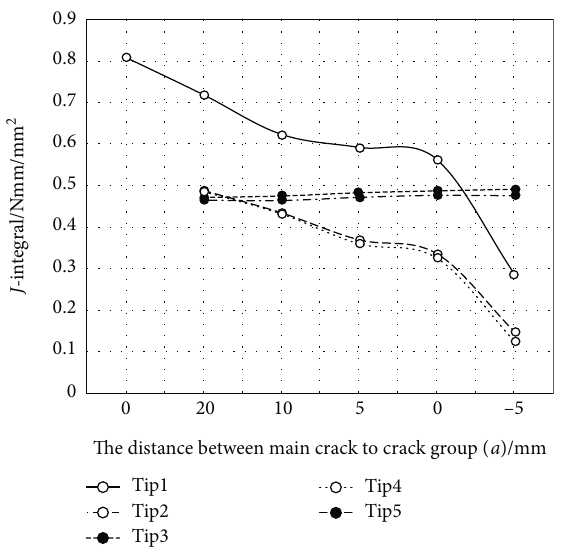
Figure 5: The J -integral variation with second crack of double collinear